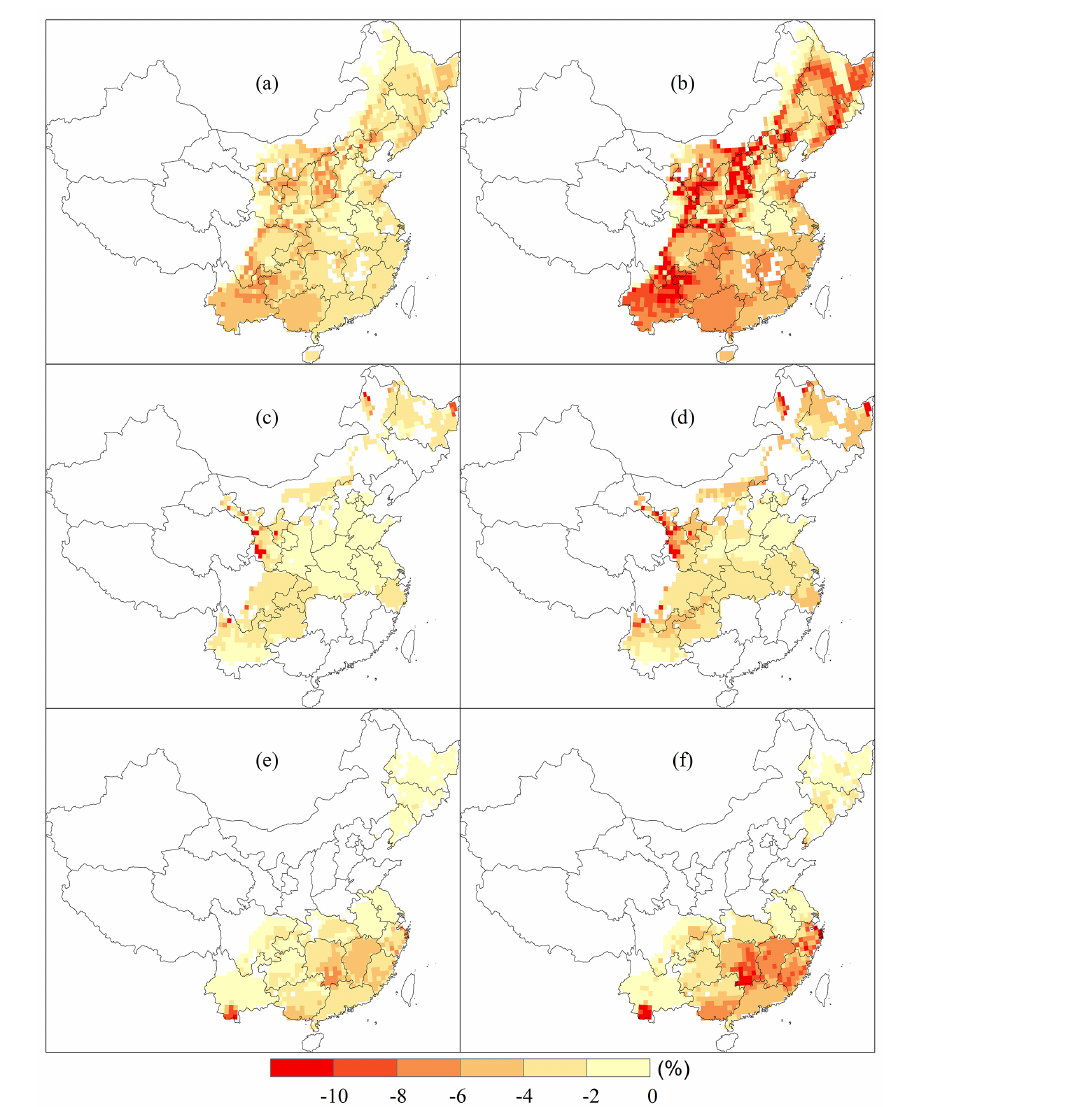
Figure 3. Median changes in growth duration for maize (a, b) , wheat (c, d) and rice (e, f) during 2106–2115 under the 1.5 ◦ C warming (a, c, e) and 2.0 ◦ C warming (b, d, f) scenarios relative to